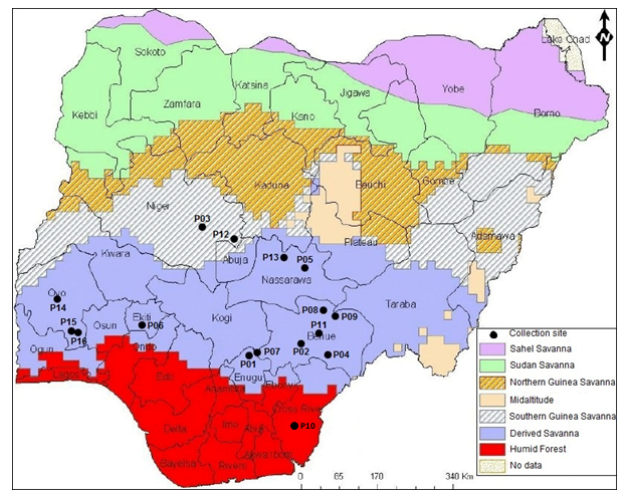
Figure 1. Map of Nigeria showing agroecological zones of the collection sites of sixteen Parkia biglobosa